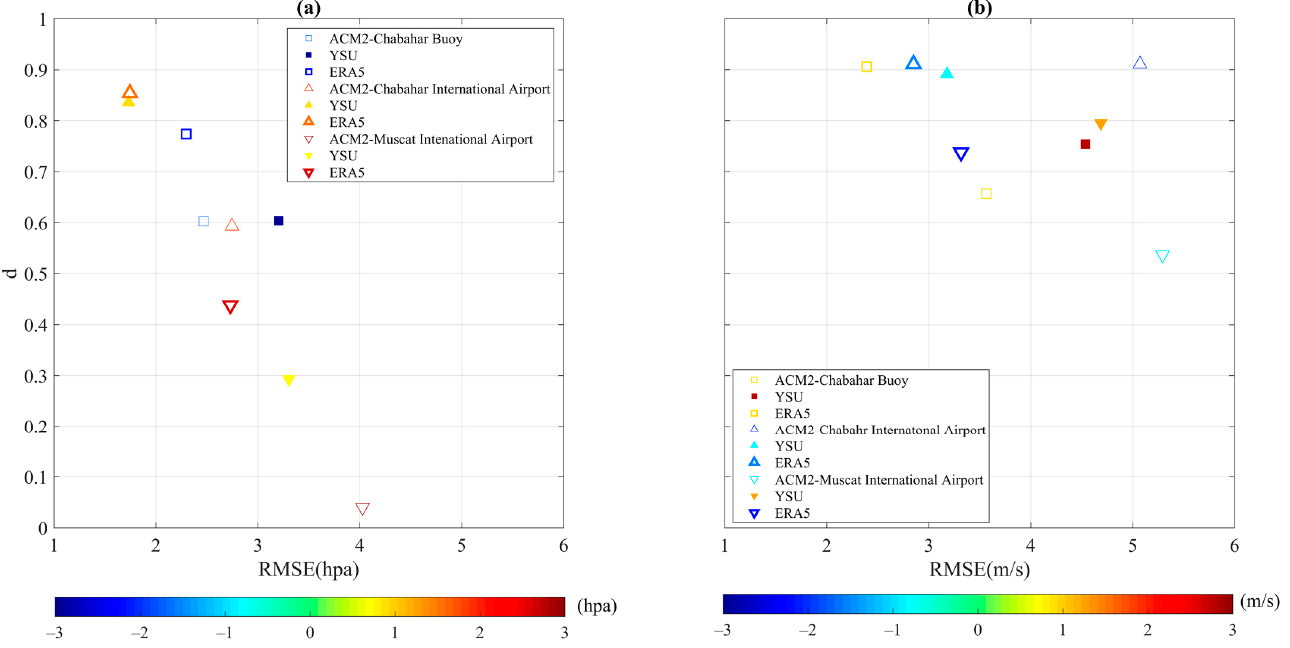
Figure 7. Estimated MBE , RMSE , and d for ( a ) sea level pressure and ( b ) wind speed at Chabahar buoy (square), Chabahar International Airport (upward triangles), and Muscat International Airport (downward triangles) by applying ACM2 (plain markers with light edges), YSU (solid markers), and ERA5 (plain parkers with tick edges). Color bars in ( a , b ) represents MBE score for sea level pressure and wind speed, respectively.